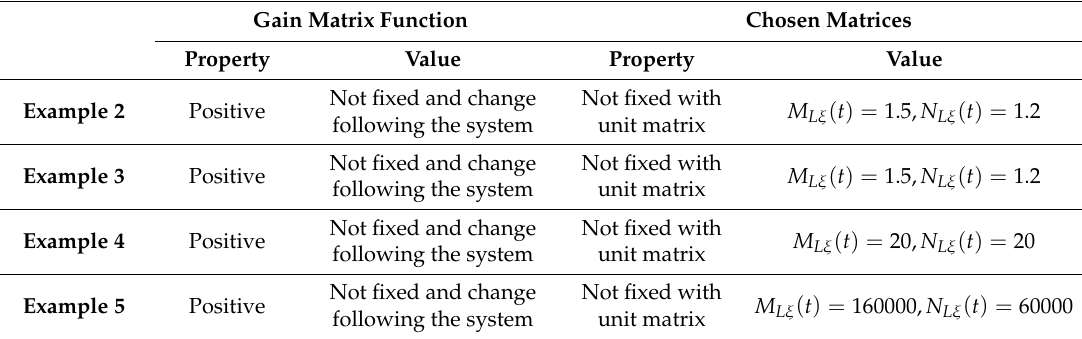
Table 1. Summarization of gain matrix function and chosen matrices of